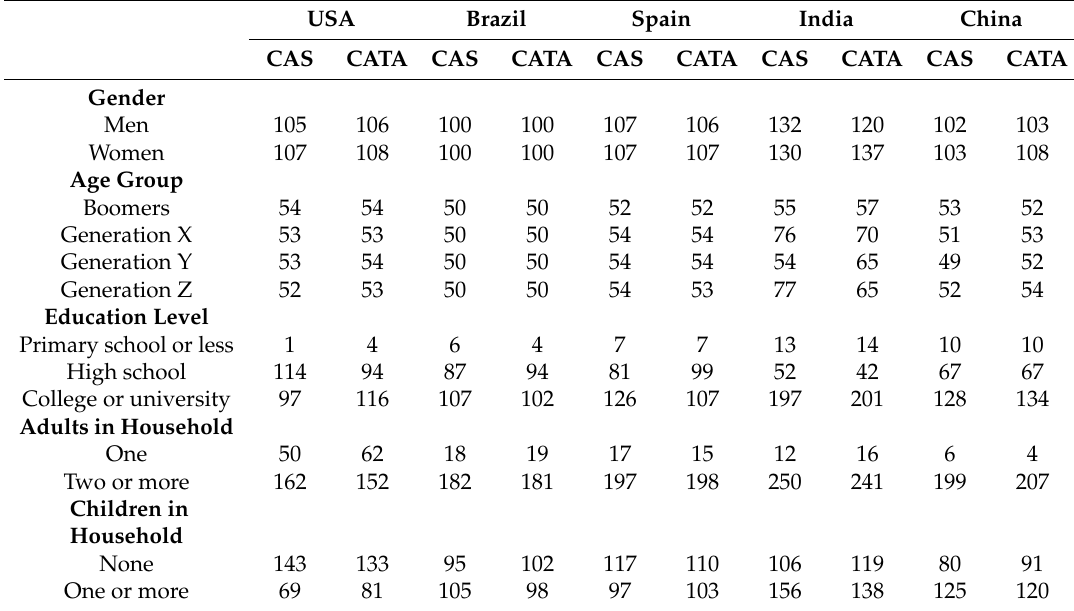
Table 3. Overview of demographic segmentation of respondents who completed the CAS and CATA question formats of the EMS in all five countries 1